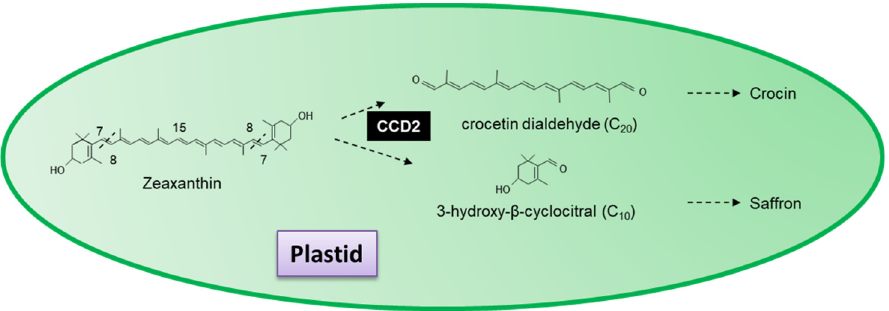
Figure 8. Scheme for the 7,8(7 ′ ,8 ′ ,) reactions catalysed by the recombinant carotenoid cleavage deoxygenases 2 in Crocus sativus .